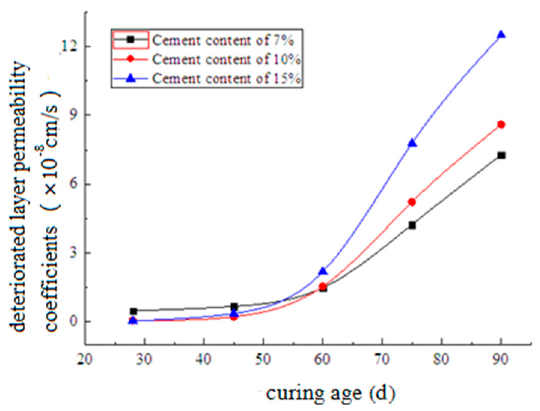
Figure 12. Development of the deteriorated layer permeability coefficients.